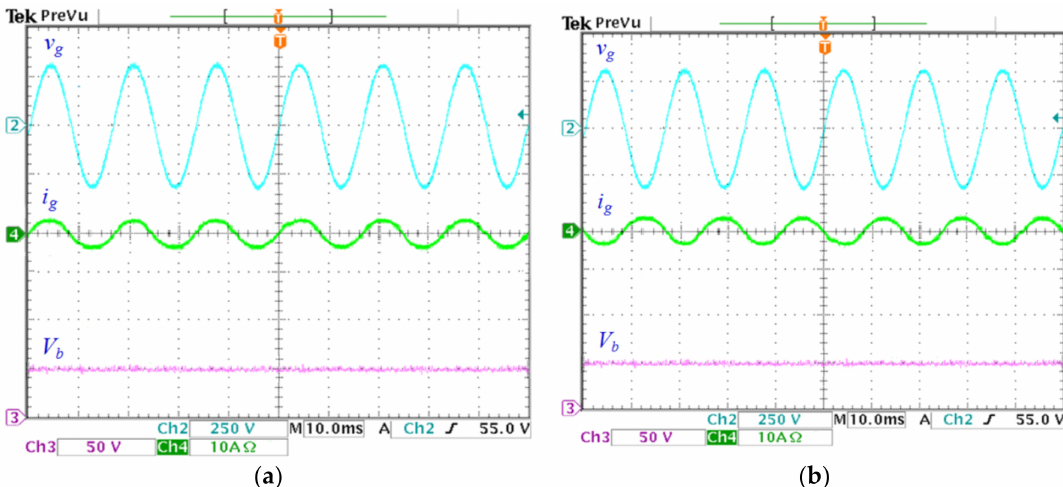
Figure 5. Experiment waveforms for the grid voltage v g , the grid current i g , and the battery voltage V b : ( a ) waveforms in the inverter mode; ( b ) waveforms in the rectifier